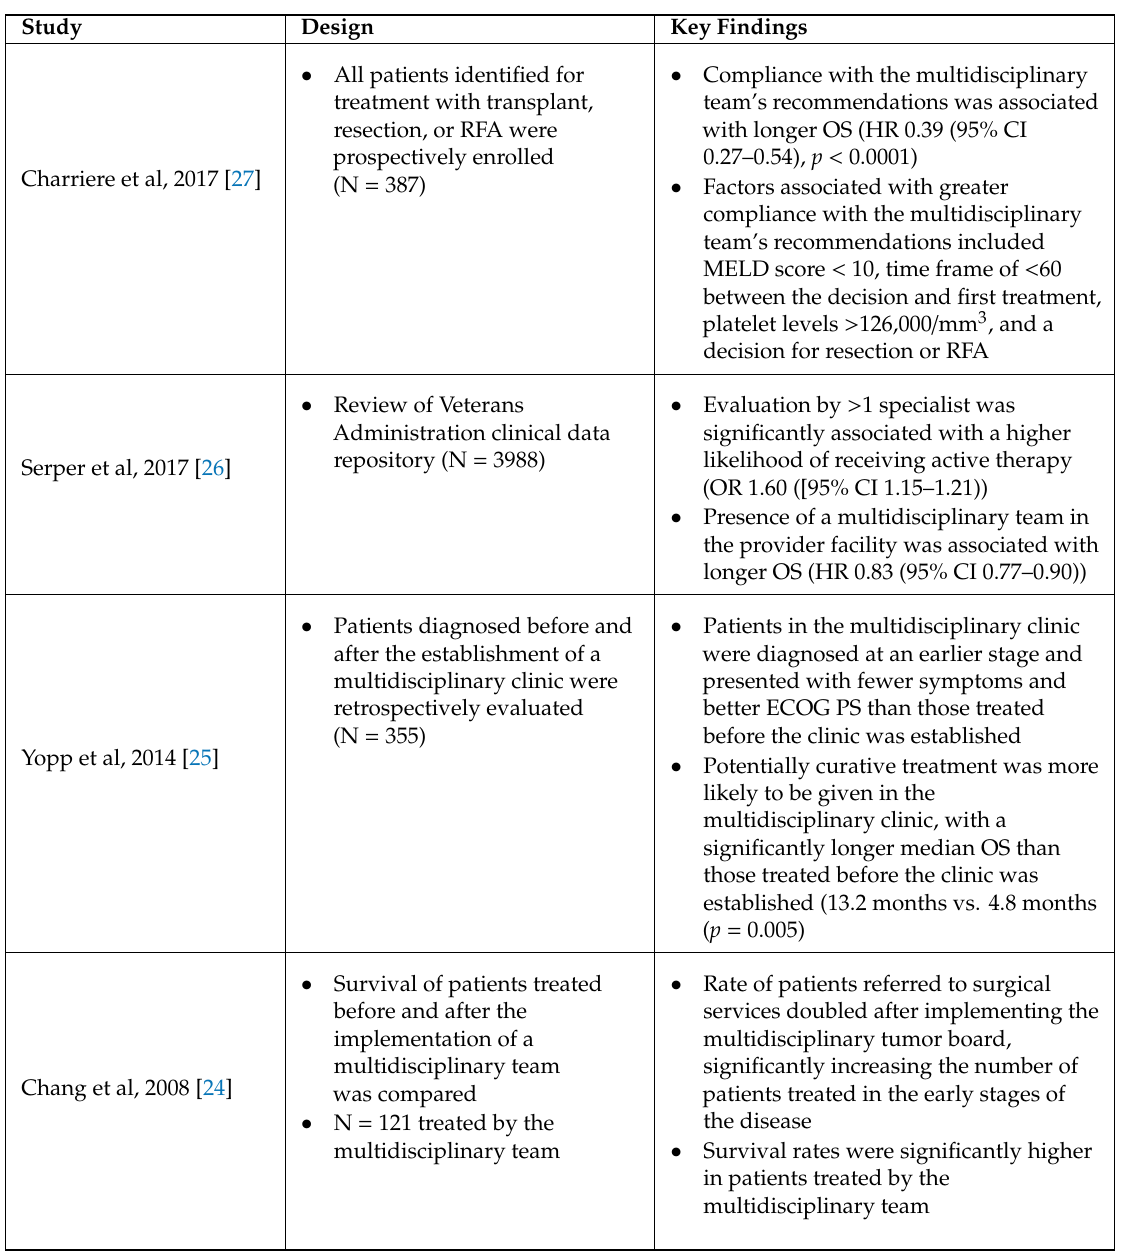
Table 2. Summary of recent studies on multidisciplinary care in unresectable